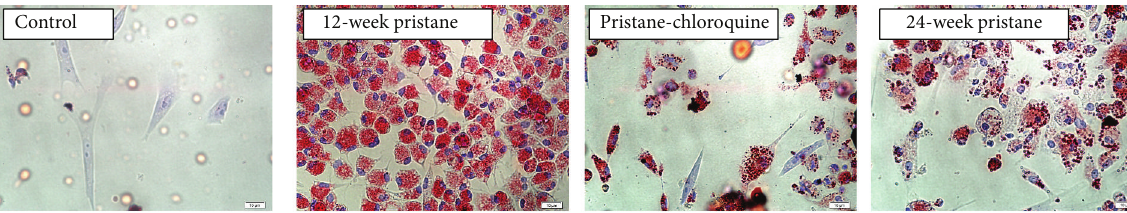
Figure 3: Macrophage phagocytic function revealed by oil red O staining. Peritoneal macrophages were exposed to 500 ng/mL ox-LDL for 24 h.